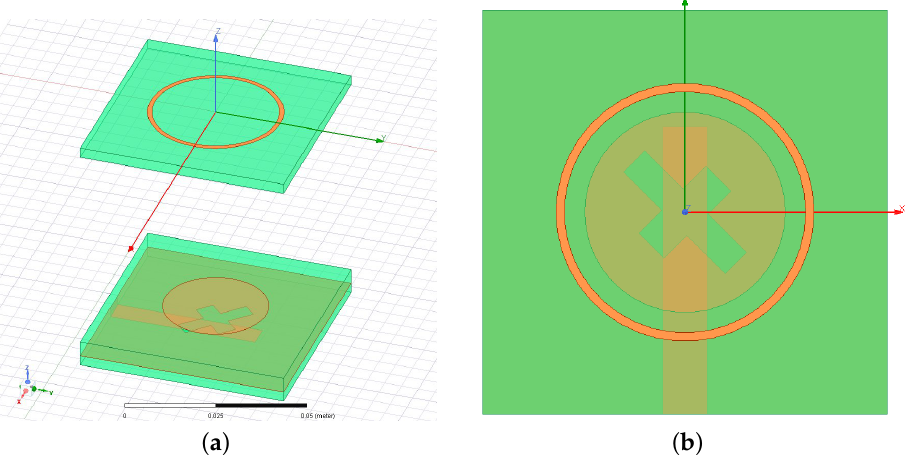
Figure 3. Numerical assessment ( [ f min , f max ] = [ 2.3, 2.6 ] [GHz])— SbD -optimized layout of the designed WWCS antenna. ( a ) 3D view and ( b ) top view.